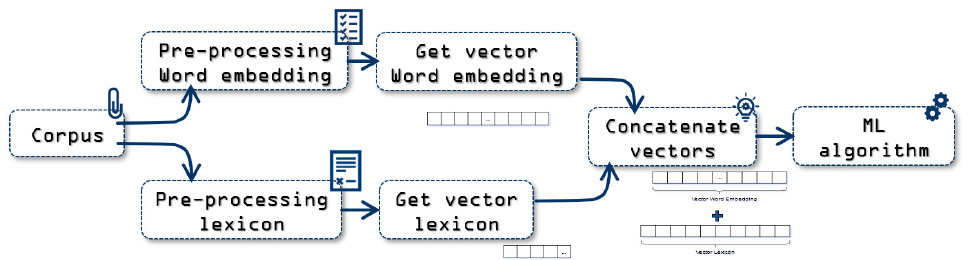
Figure 6. Process approach WE_Lexicon.